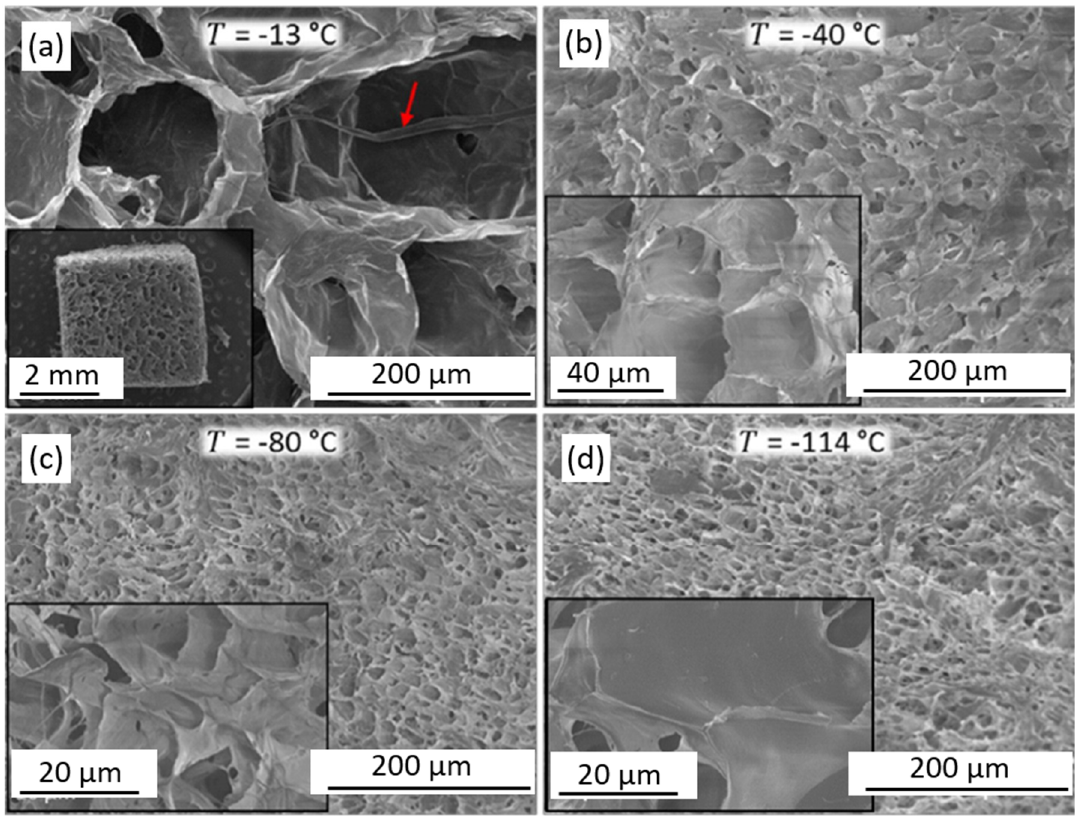
Figure 11. SEM micrographs of CNF foams obtained after freezing at various temperatures and then sublimation. The images inset are SEM micrographs of CNF foams obtained at lower ( a ) or higher ( b- d ) magnifications (Adapted from Martoïa et al. [56] with permission from Elsevier).